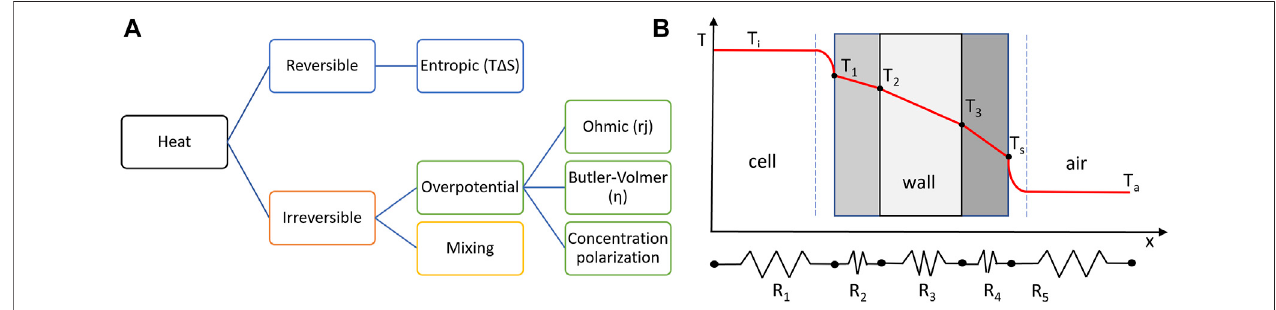
FIGURE 6 | A common illustration of (A) heat generation categories in batteries, (B) the heat transfer mechanism from inside the cell to the surrounding